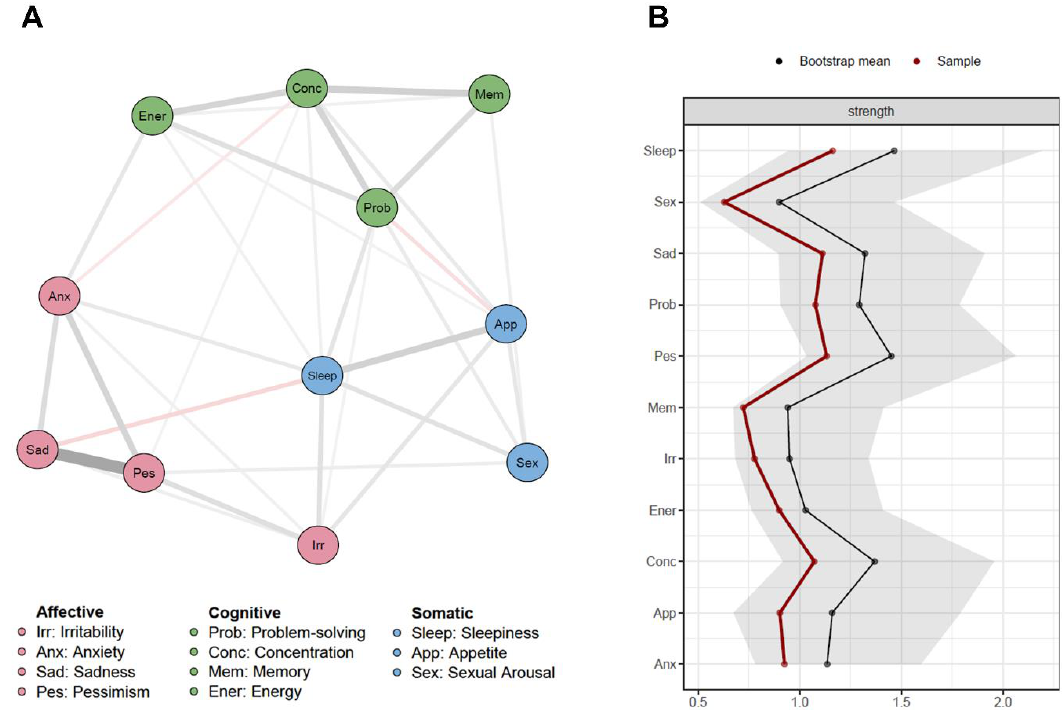
Figure 2. MRhI-r network. ( A ) Lasso (least absolute shrinkage and selection operator) correlations network containing the 11 items that compose the MRhI-r. Thicker lines represent stronger correlations. Gray lines stand for positive correlations and red lines for negatives correlations. ( B ) Node strength estimates ( n = 1275), including bootstrapped 95% confidence intervals.